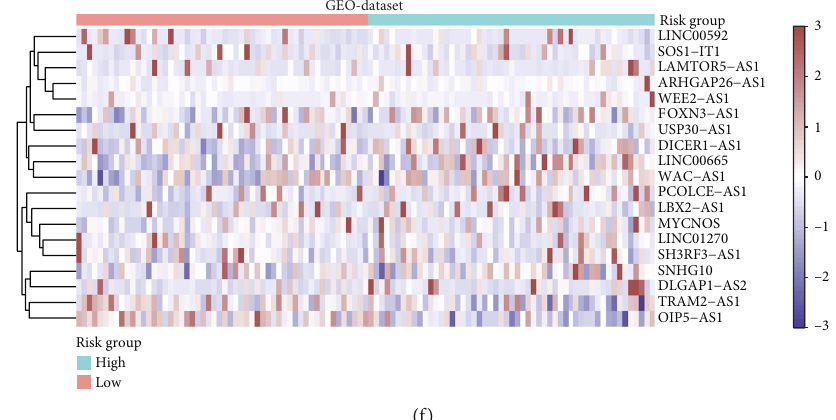
Figure 1: Identi fi cation of a 16 N6-methyladenosine-associated lncRNA m6A score via LASSO regression. (a) LASSO regression. (b) Coe ffi cient value of 16-N6-methyladenosine-associated lncRNA. (c) Risk score of TCGA cohort. (d) Risk score of GEO cohort. (e) Heatmap of 16 N6- methyladenosine-associated lncRNA expression in TCGA dataset. (f) Heatmap of 16 N6-methyladenosine-associated lncRNA expression in GEO